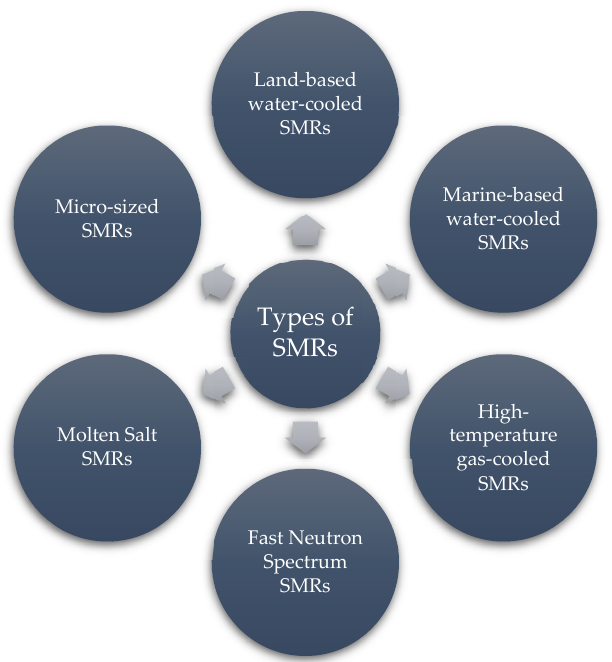
Energies 2023 , 16 , x FOR PEER REVIEW Figure 1. SMR classification scheme from the IAEA. Figure 1. SMR classification scheme from the IAEA.